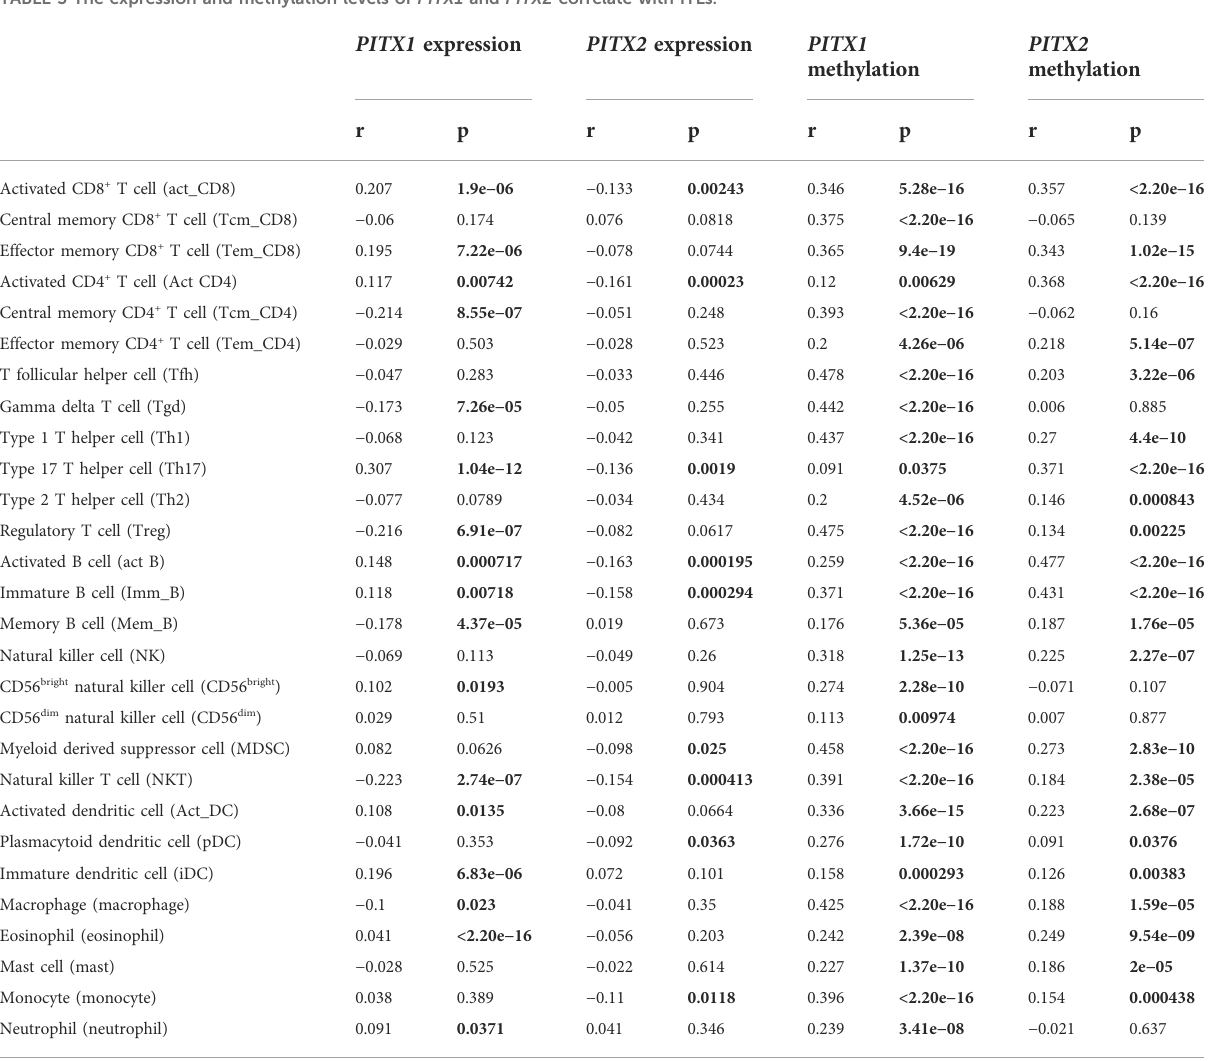
TABLE 3 The expression and methylation levels of PITX1 and PITX2 correlate with